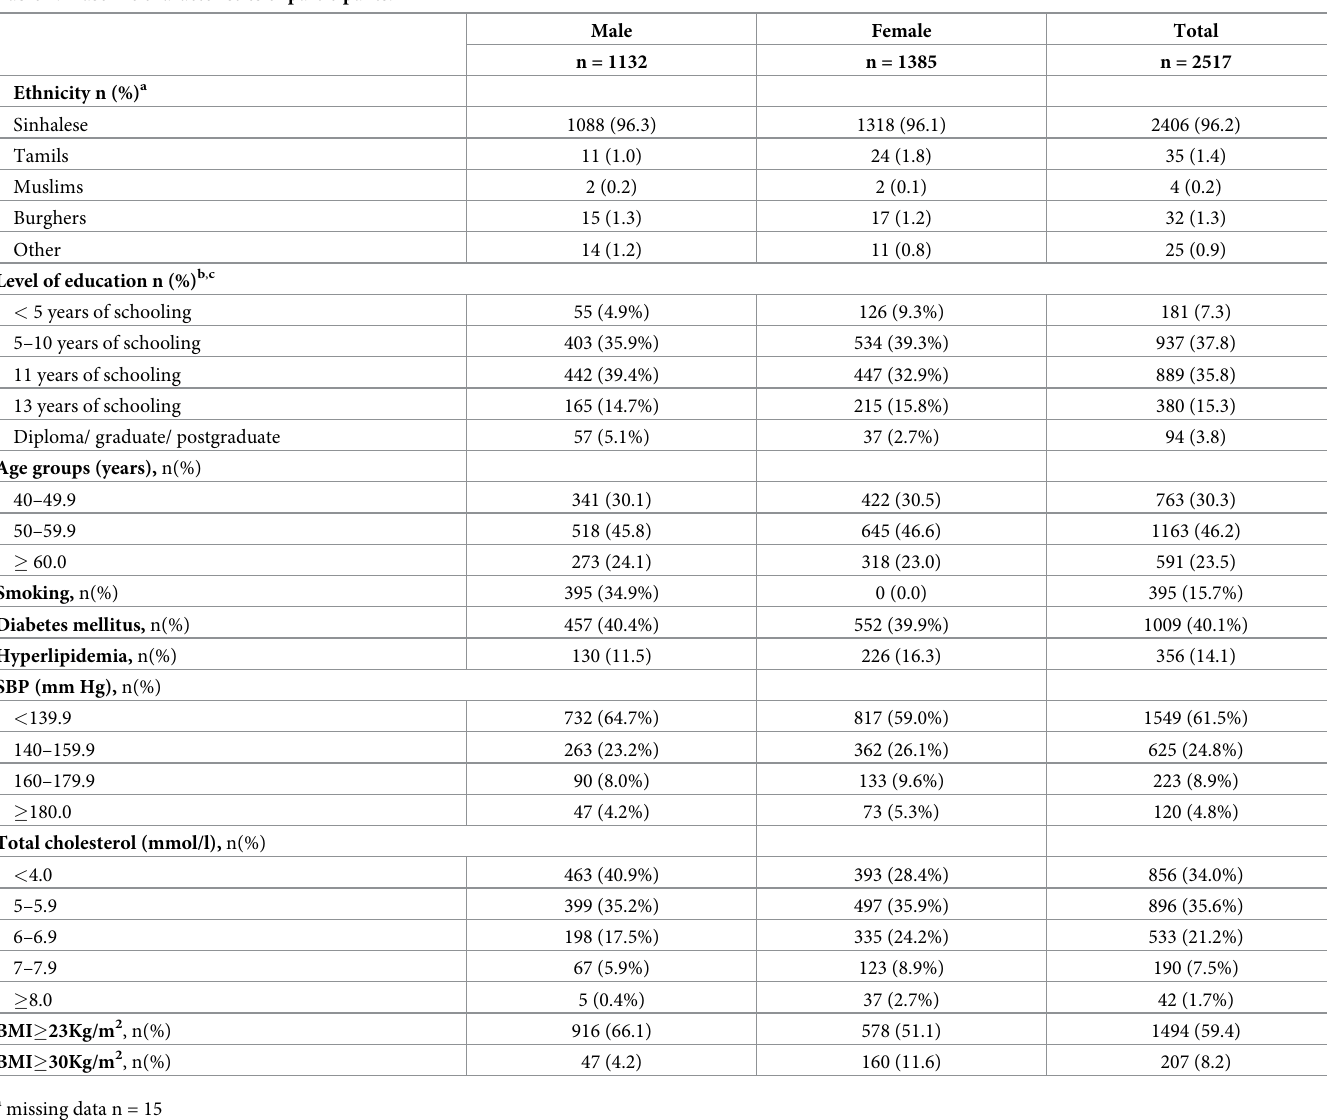
Table 2. Baseline characteristics of